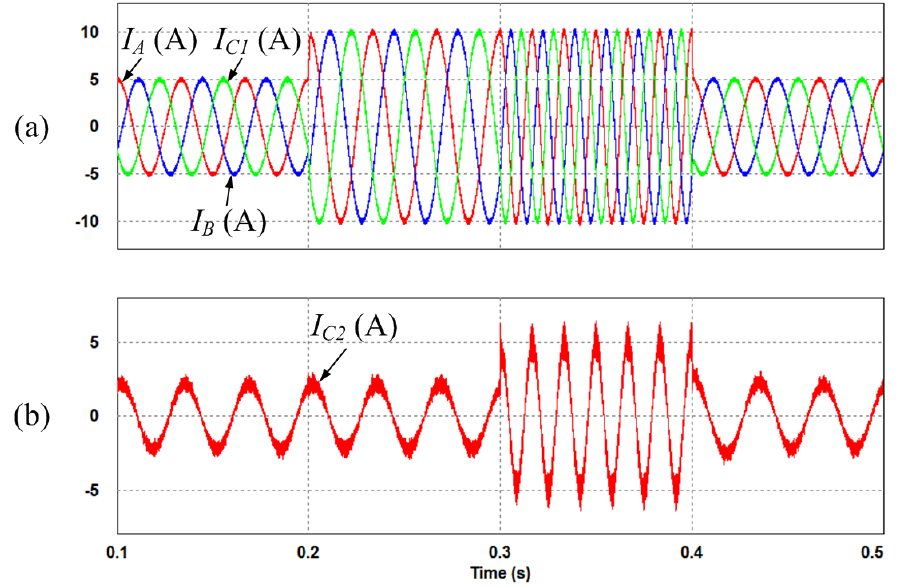
Figure 11. Simulation results of dynamic response: ( a ) output currents in the three-phase load; ( b ) output current in the single-phase